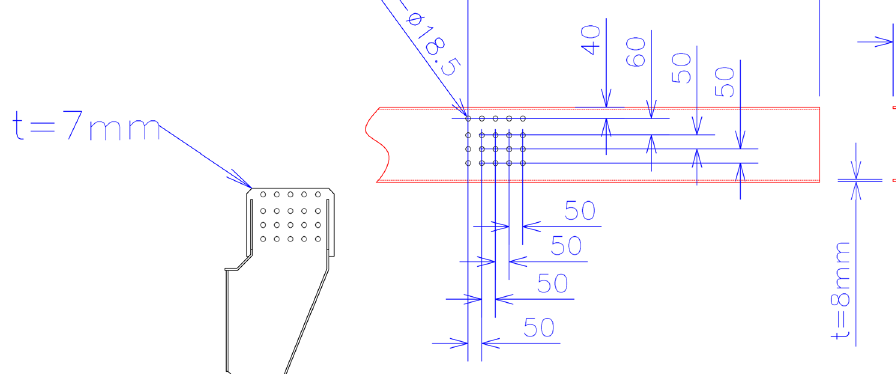
Fig. 2 Location and distances of holes in lift axle mounting bracket